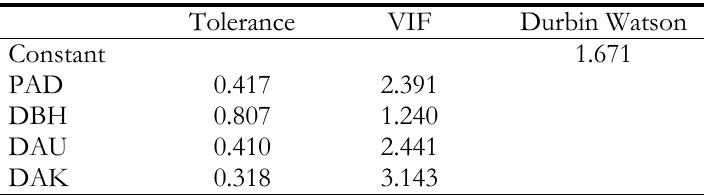
Table 2. Ordinary Least